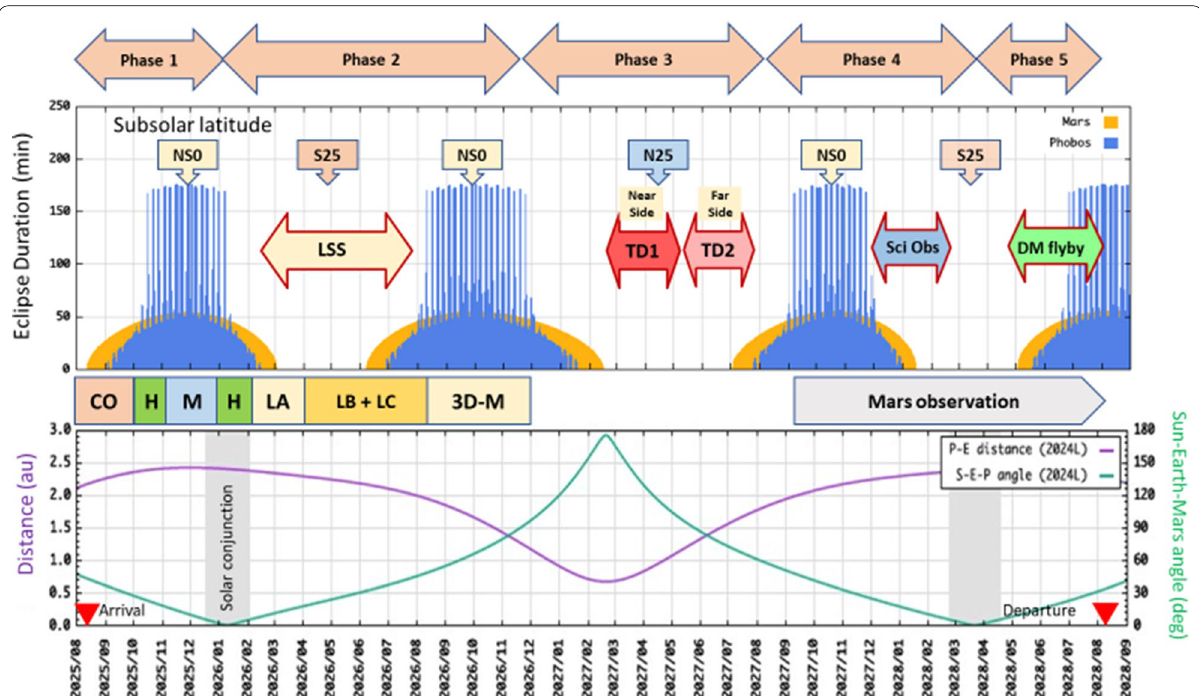
Fig. 1 Current scientific operation plan for Phobos (Phase 1 to 4) and Deimos (phase 5). Two times touch down on near side and far side of the moon are planned in phase 3, but the time and locations are tentative. Mars observation will take place mainly in Phase 4 and 5 together with Phobos and Deimos observation. Top panel indicates solar latitude (NS0, S25, and N25 mean β duration in minutes by Mars (orange) and Phobos (blue). For eclipse duration estimates, a QSO‑L orbit is assumed. In between the top and bottom panel, type of QSOs (H, M, LA, LB, LC, and 3D‑M) that will be performed in corresponding time period are described for the first 1.5 years (QSO allocation for the last 1.5 years are not yet determined). The allocated period of 3D‑M is tentative. Bottom panel indicates solar conjunction period (Grey) and the distance between Phobos and Earth (purple line in au) and Sun‑Earth‑Mars angle (green in deg.). CO check out, H QSO‑H, M QSO‑M, LA QSO‑LA, LB QSO‑LB, LC QSO‑LC, 3D-M 3D‑QSO, LSS landing site selection, TD touch down, Sci Obs scientific observation for Phobos, DM flyby Deimos flyby